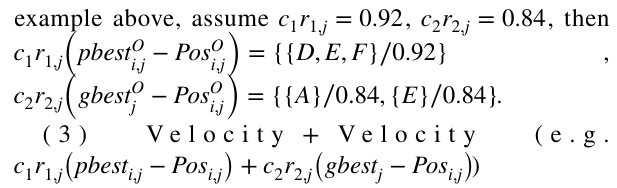
Fig. 3 An example for explanation of operators in